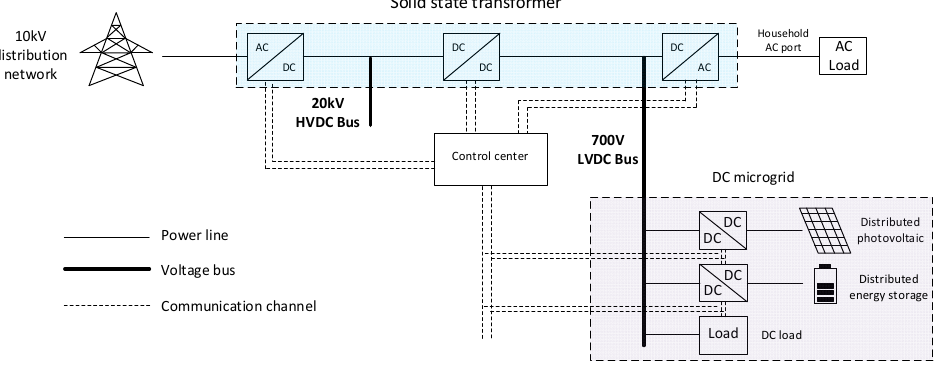
Figure 3. Topology of a DC microgrid system.